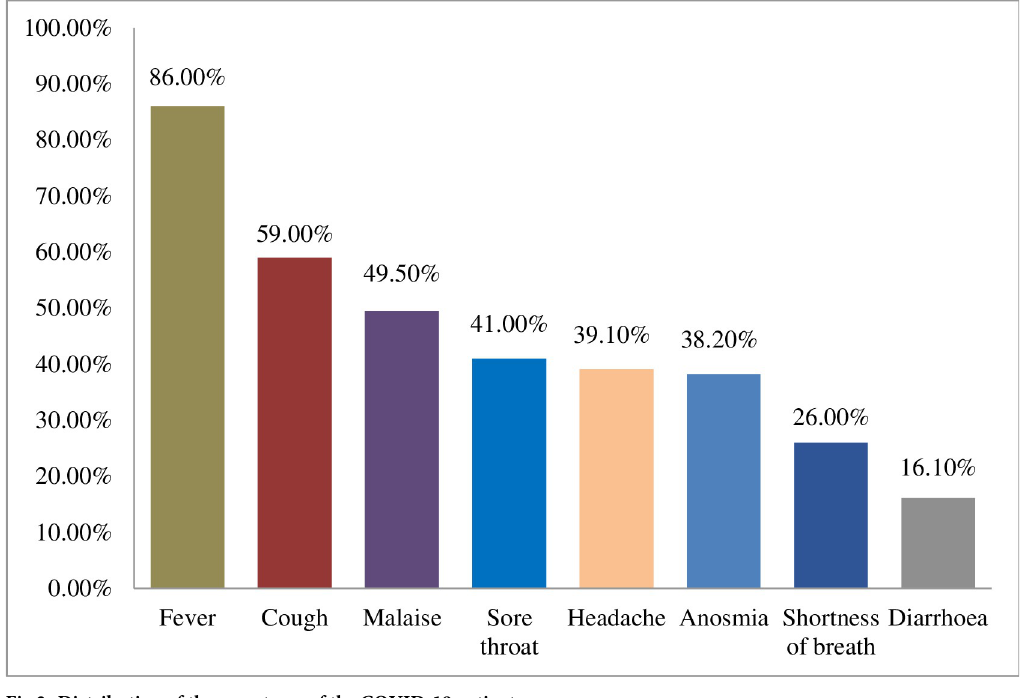
Fig 2. Distribution of the symptoms of the COVID-19 patients.